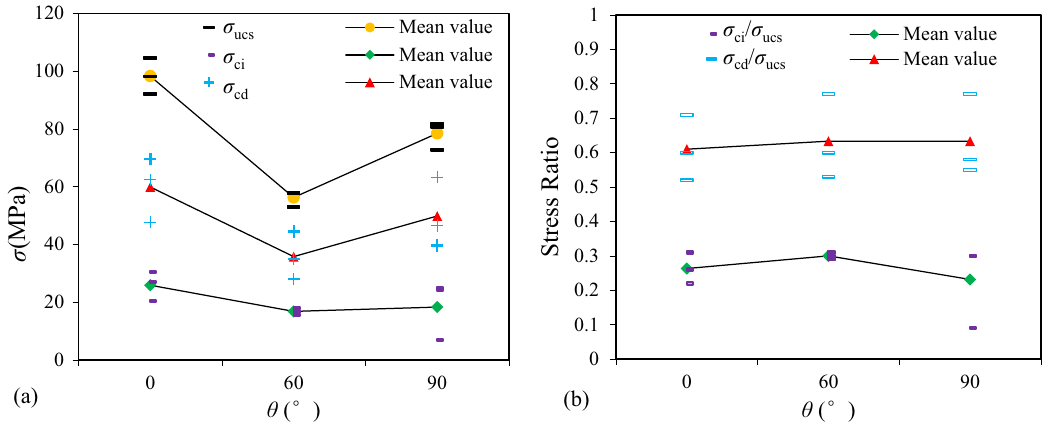
Figure 5. Plots of mean values of ( a ) σ ucs , σ ci , σ cd and ( b ) σ ci / σ ucs , σ cd / σ ucs of shale specimens of groups A, B and C for each bedding dip